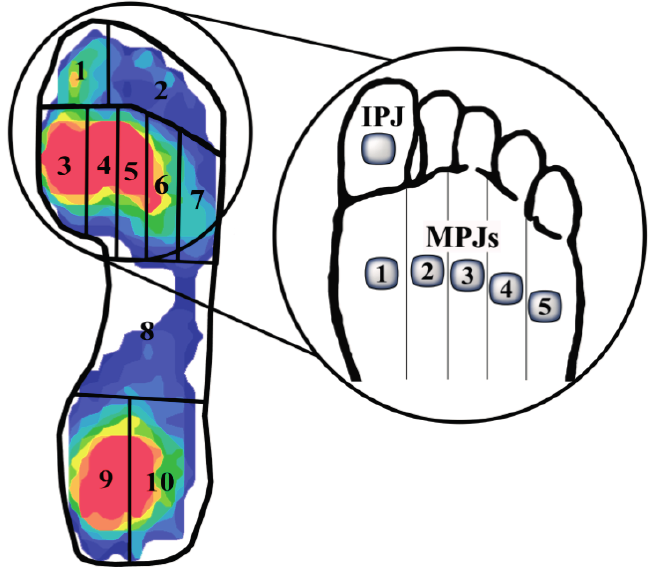
Figure 2. Mask of the 10 anatomical regions of interest in the foot. The magnified area highlights the joints at which pressure values were extracted from regions 1,